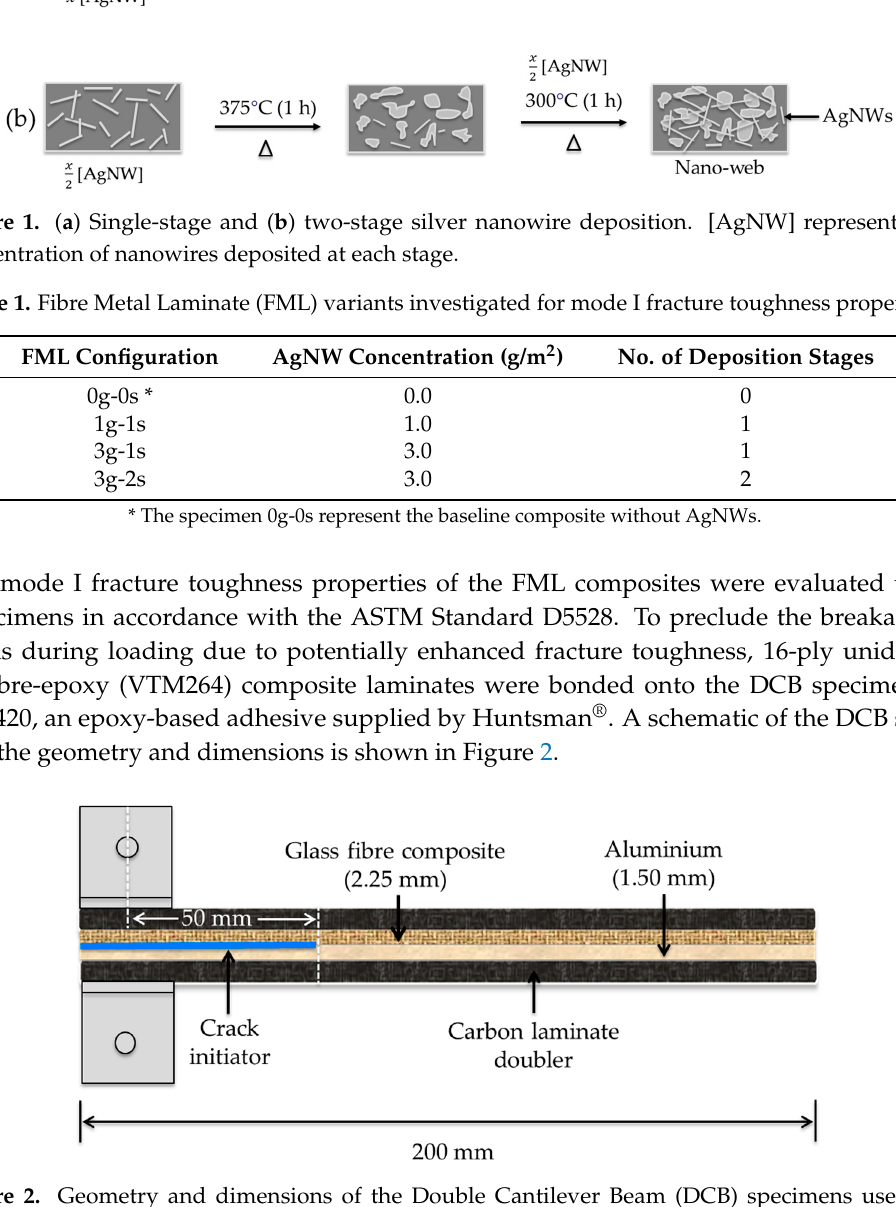
Figure 2. Geometry and dimensions of the Double Cantilever Beam (DCB) specimens used for measuring the fracture toughness properties.